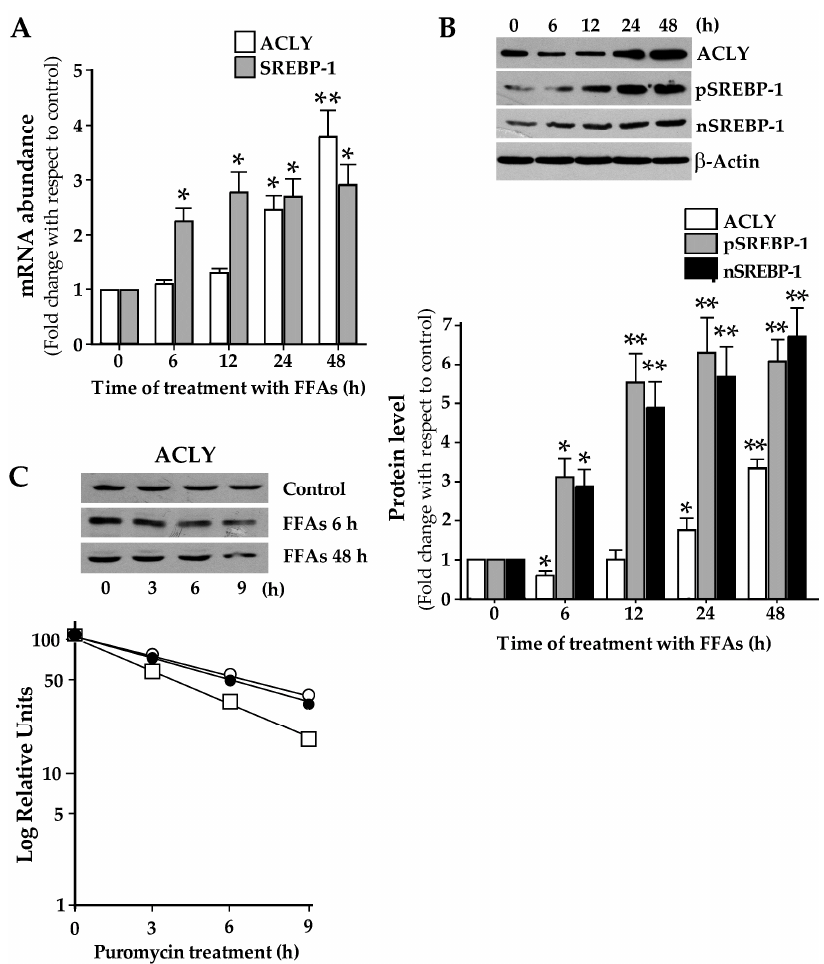
Then ACLY levels showed a constant increase, becoming about 3.5-fold greater than the control after 48 h of treatment (Figure 1B). In agreement with previous results [9], treatment with FFAs caused an increment of SREBP-1 mRNA abundance (Figure 1A). The content of precursor (pSREBP-1) and active nuclear (nSREBP-1) of SREBP-1 protein increased in FFAs-treated cells with respect to control (Figure 1B).